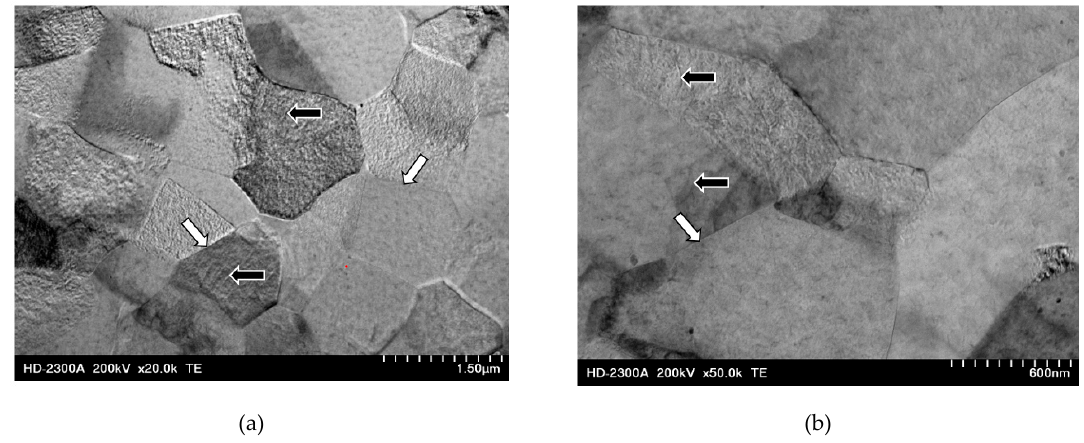
Figure 9. STEM micrographs KoBo extruded Mg-Csf composite demonstrated effect of matrix refining; straight grain boundaries (white arrows), dislocations (black arrows).